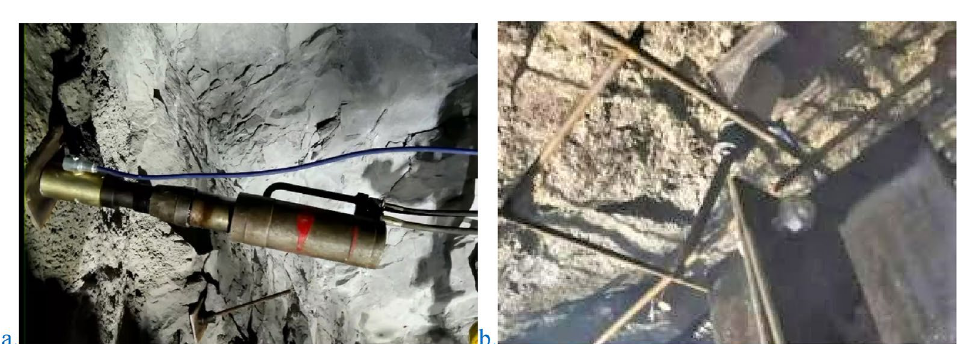
Figure 19. Real scene of the tensioning machine and the rock bolts. ( a ) Tensioning machine; ( b ) rock